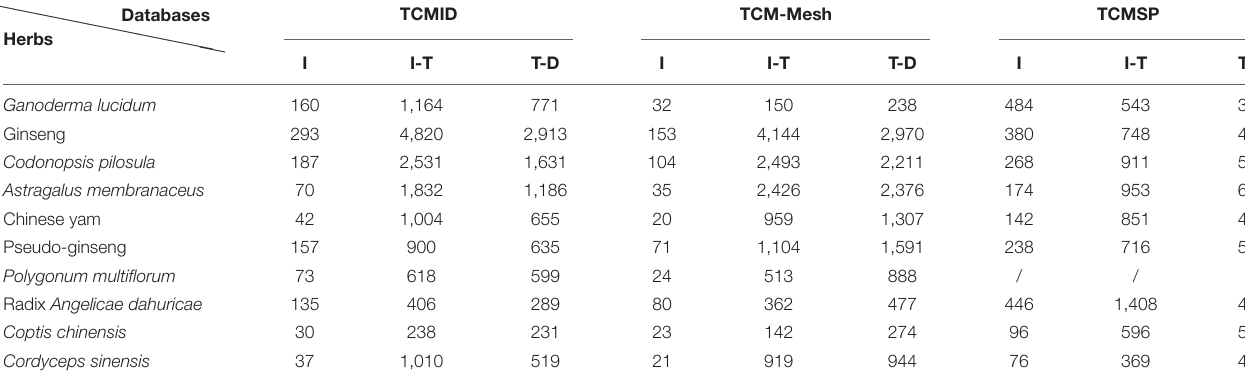
TABLE 6 | Search results of 10 well-known TCMs from three TCM